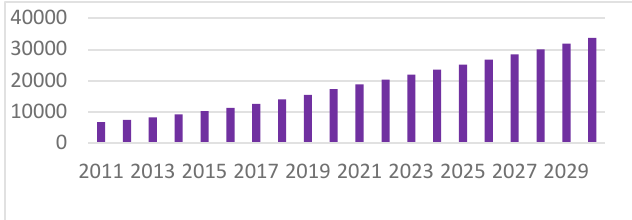
Table 1: Daily Power Generation